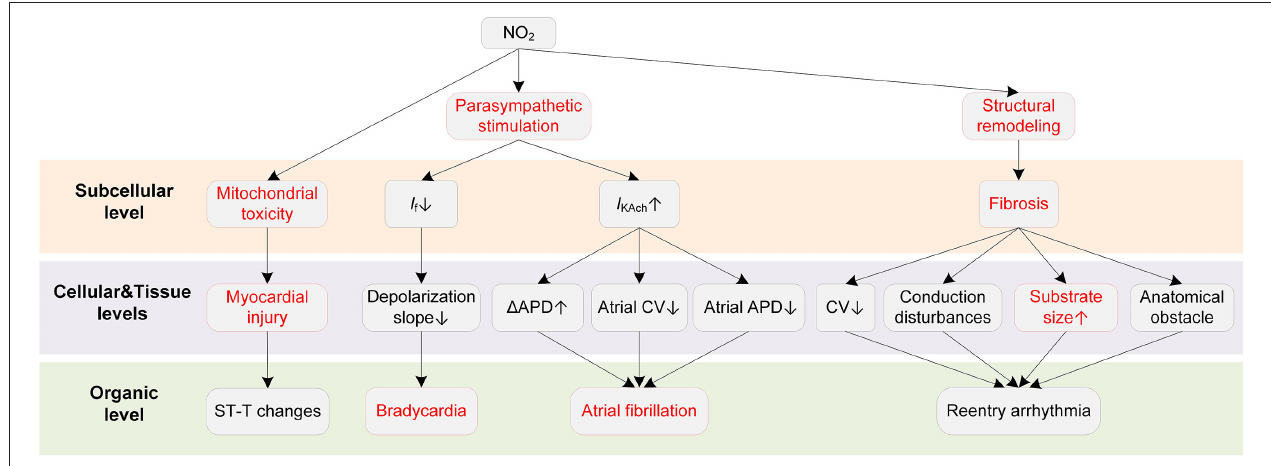
FIGURE 7 | Potential mechanisms underlying NO 2 -induced arrhythmias. Red boxes indicate effects of NO 2 that have been explicitly demonstrated.